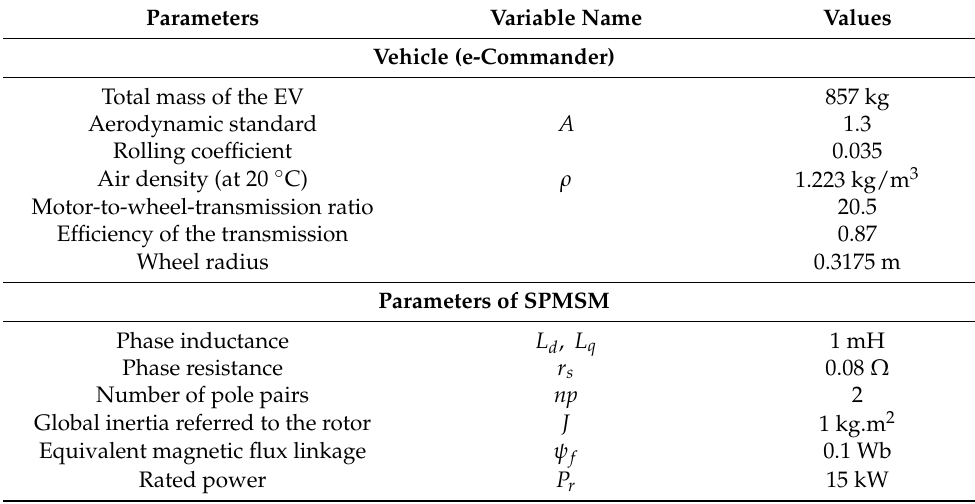
Table 2. Parameters of EV